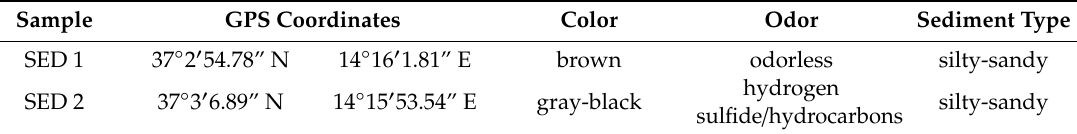
Table 1. Sampling and physical characteristics of marine sediments.